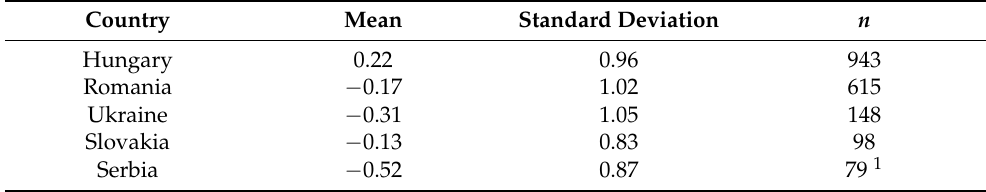
Table 2. Mean and standard deviation of the standardized social background index by country.